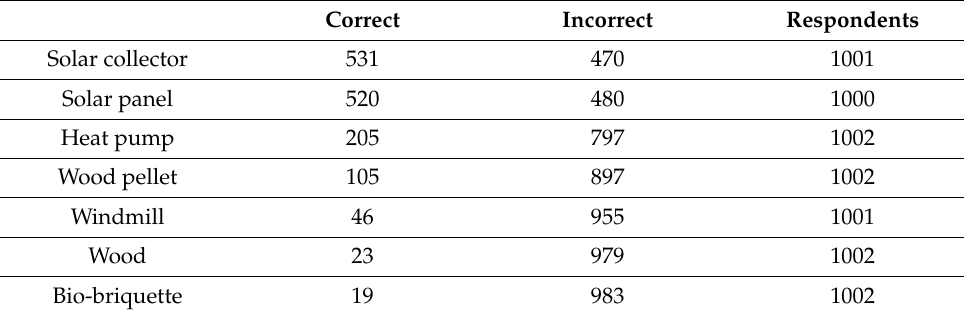
Table 8. The evaluation of responses presented in Table 7. Correct Incorrect